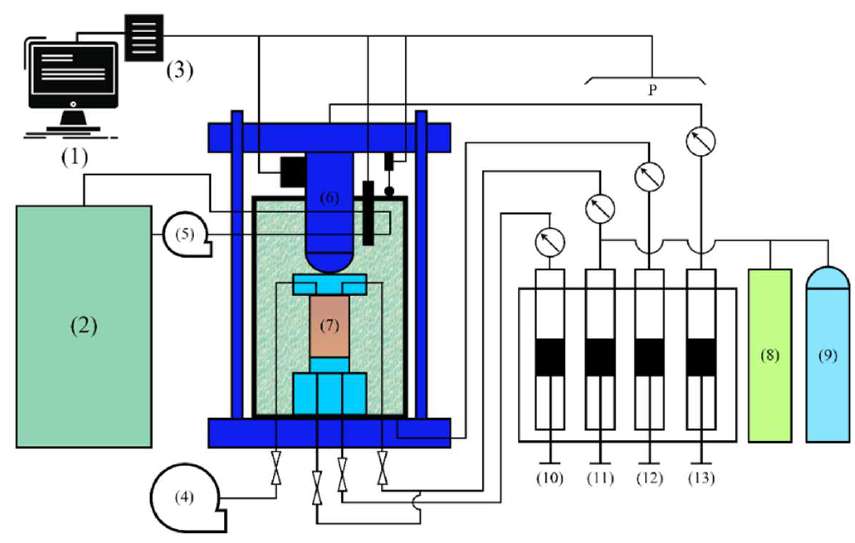
Figure 3. The schematic diagram of the triaxial testing equipment. (1) computer; (2) thermostatic bath; (3) data collection; (4) vacuum pump; (5) circulation pump; (6) axial load cell; (7) sample; (8) buffer tank; (9) gas source; (10) water pump for sample; (11) gas pump; (12) confining pressure pump; (13) hydraulic oil pump for axial load.